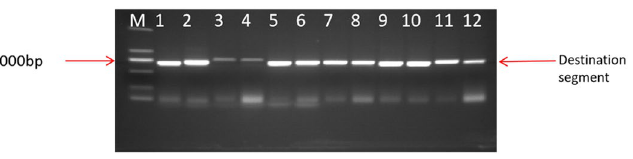
Figure 4. PCR detection of the target gene in Agrobacterium . M: 2000 bp DNA molecular marker; 1–12: transgenic lines.